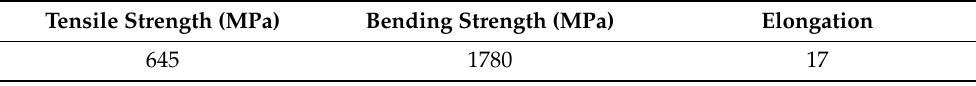
Table 3. Steel mechanical